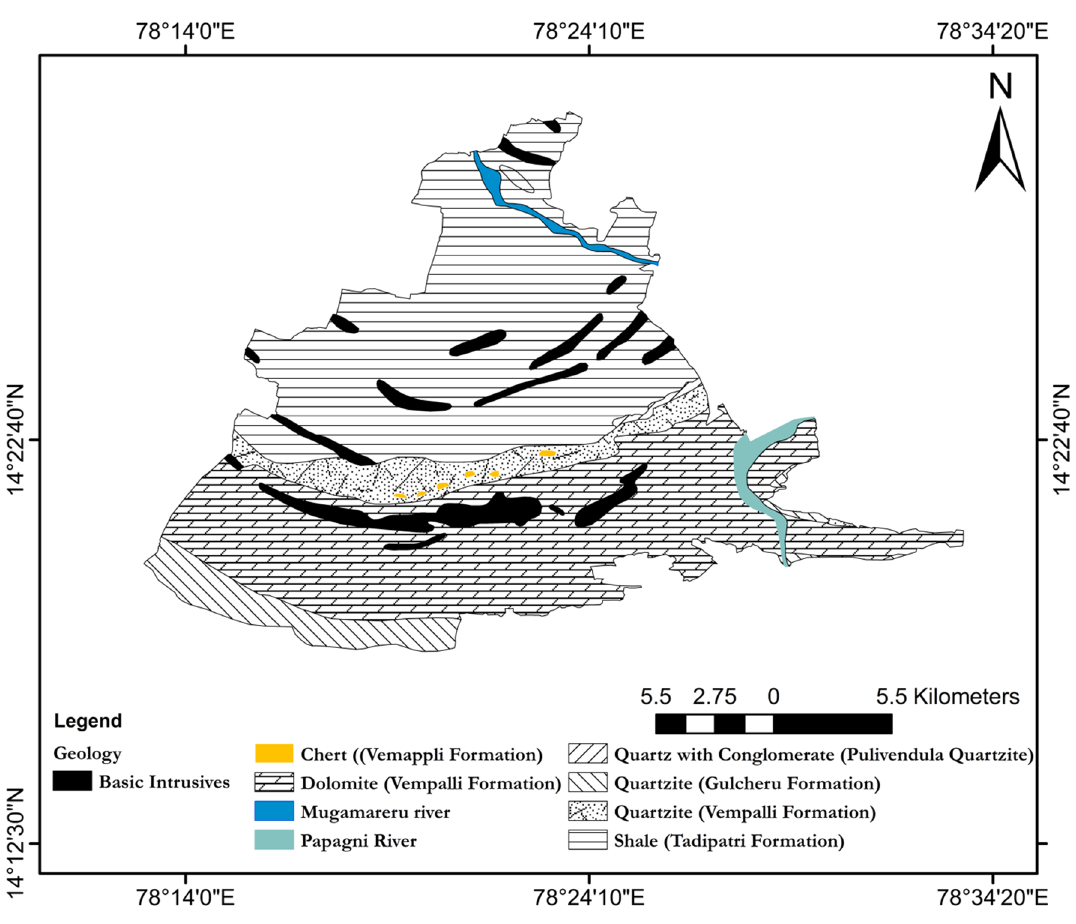
Fig. 2 Geology map of the study